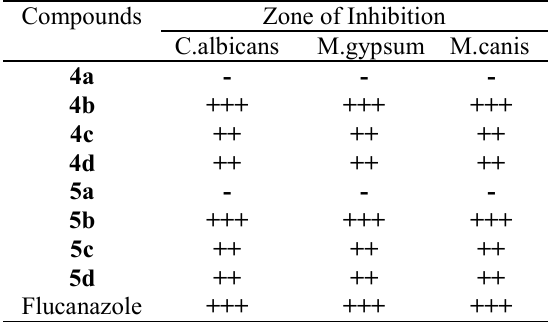
Table 1. Results of anti-fungal